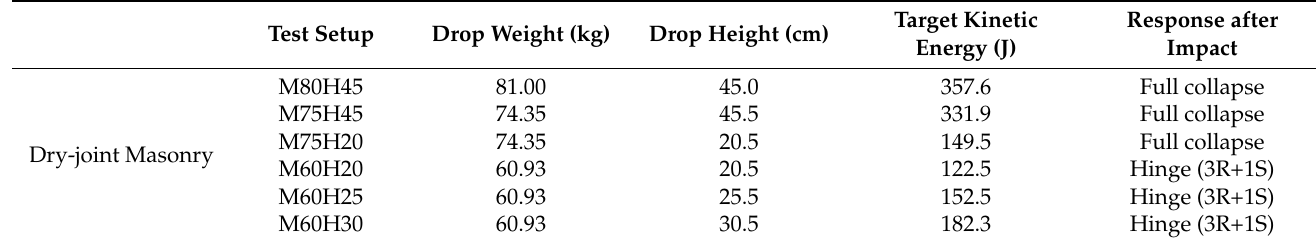
Table 2. Impact test setups and observed global response after test execution. Test